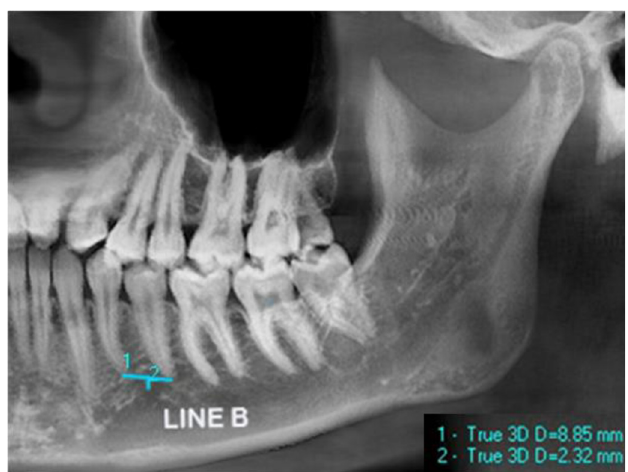
Fig. 3. Diagrammatic representation of measurements on cross-section of mandible (Sagittal section in median plane).